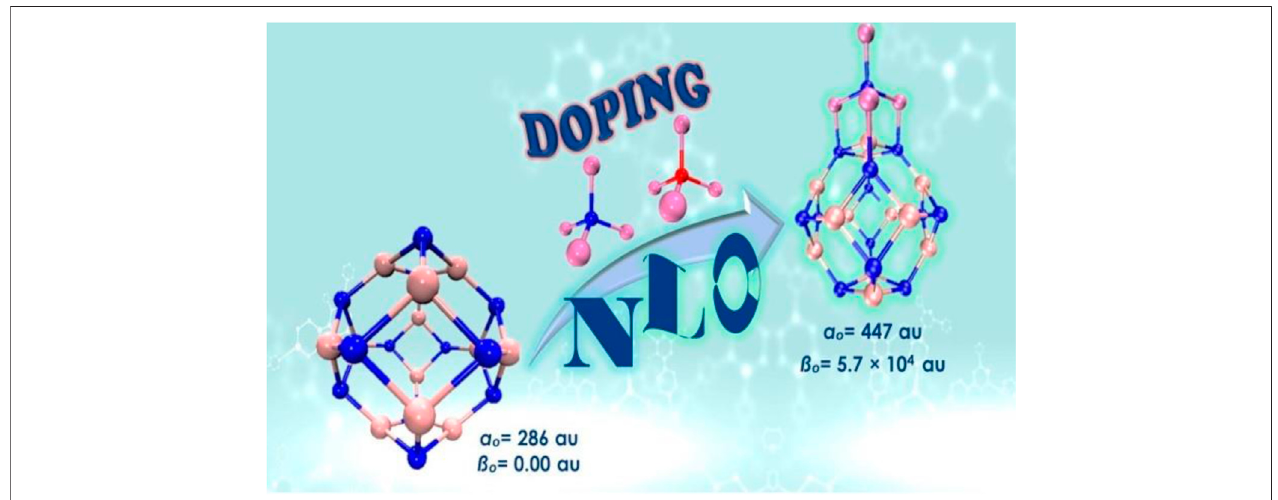
FIGURE 11 | Li 4 N@Al 12 N 12 complex with the highest hyperpolarizability of 5.7 × 10 4 au. Reprinted from Khaliq et al., 2021b with permission from Elsevier.